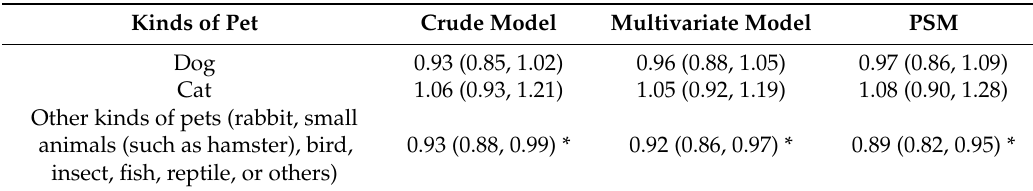
Table 5. Association between dog, cat, or other kinds of pet ownership, and children’s poor emotional expression. Kinds of Pet Crude Model